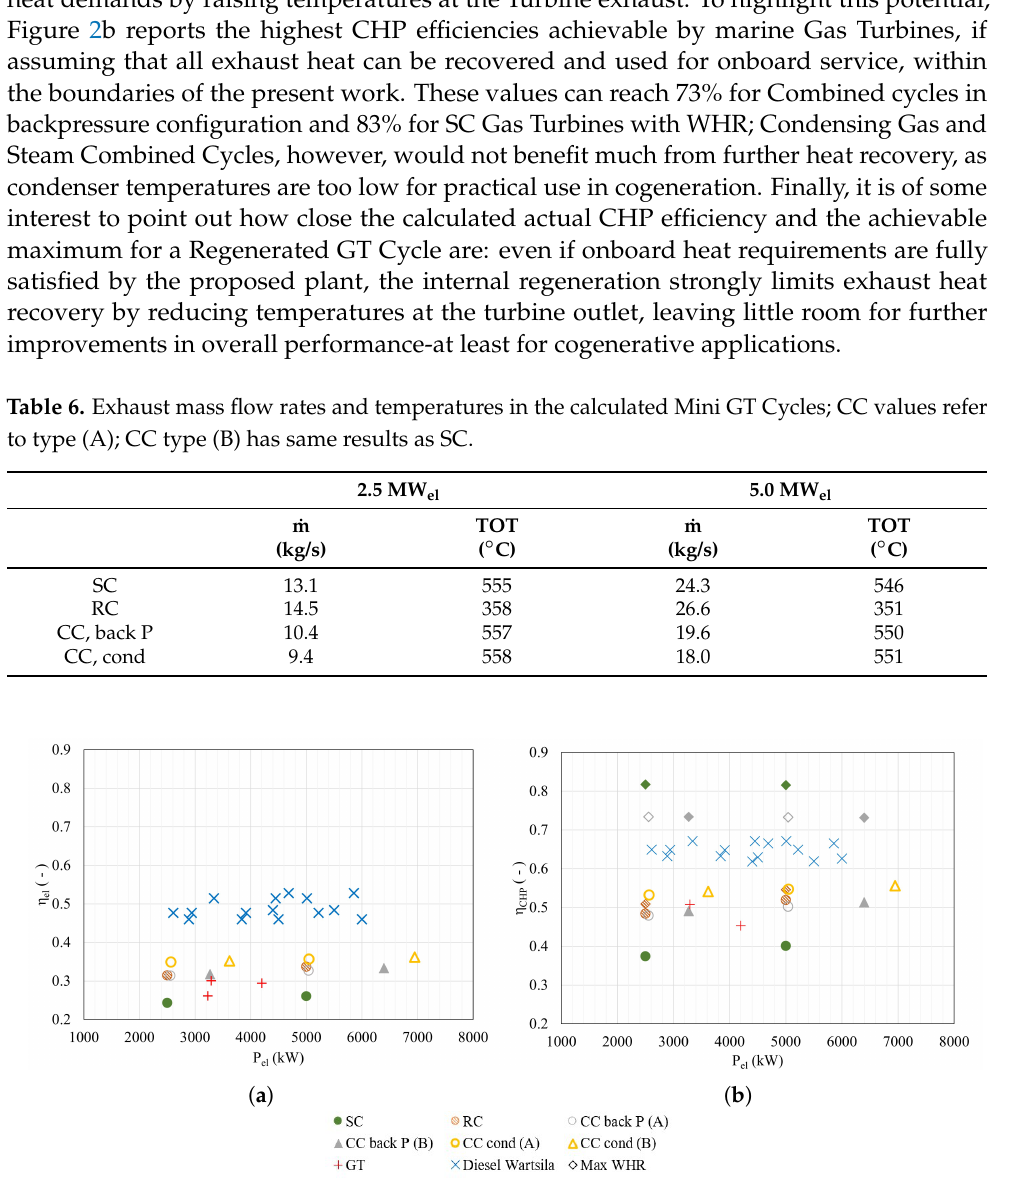
Figure 2. ( a ) Electrical and ( b ) CHP efficiency of the calculated cases, in comparison with state-of-the- art marine Engines. Diamond-shaped indicators for CHP efficiency represent maximum theoretical values, achievable if all the available heat is recovered from the exhaust down to a minimum stack temperature, according to Table